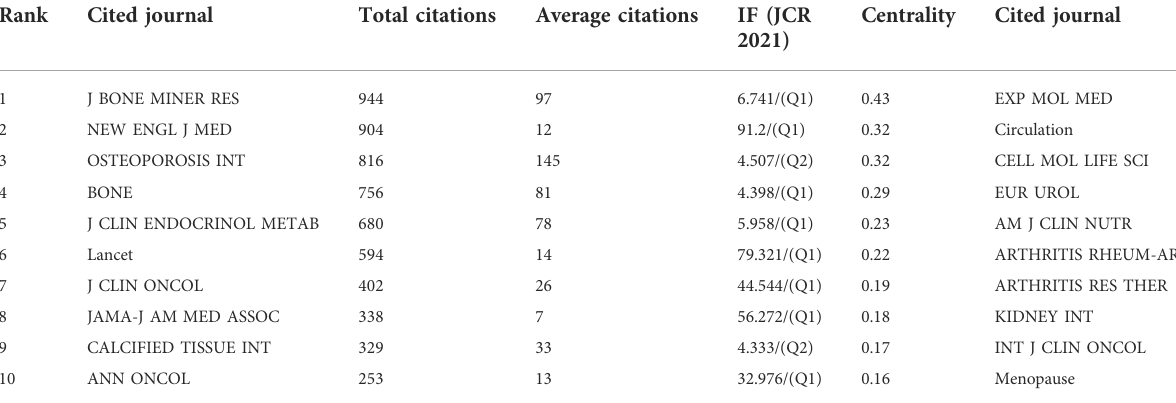
TABLE 4 Top 10 cited journals in terms of citation frequency and centrality.